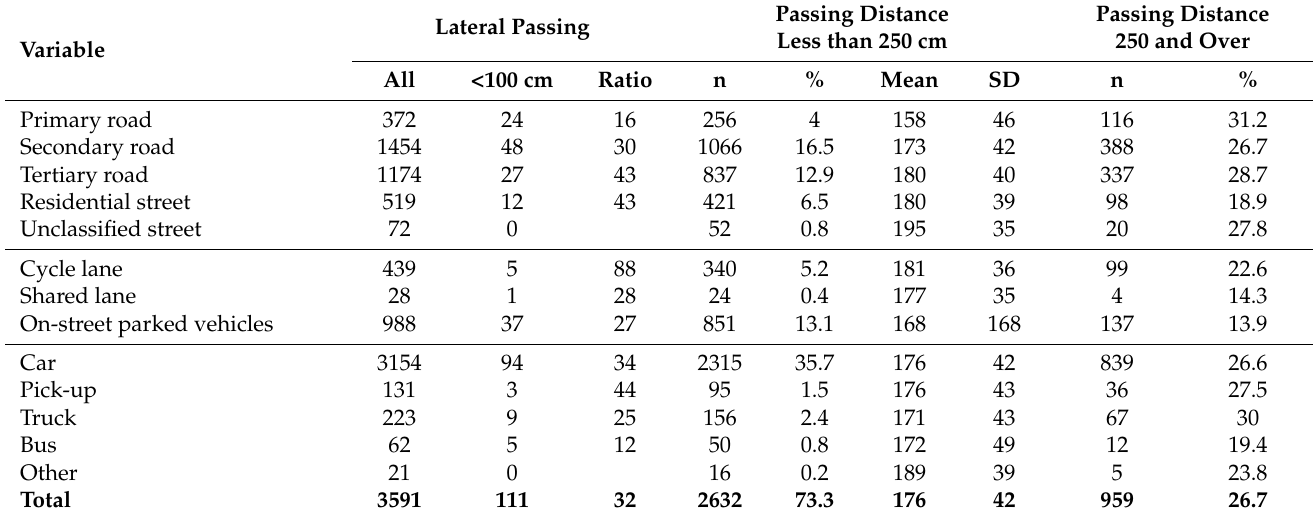
Table 2. Frequency of overtaking.